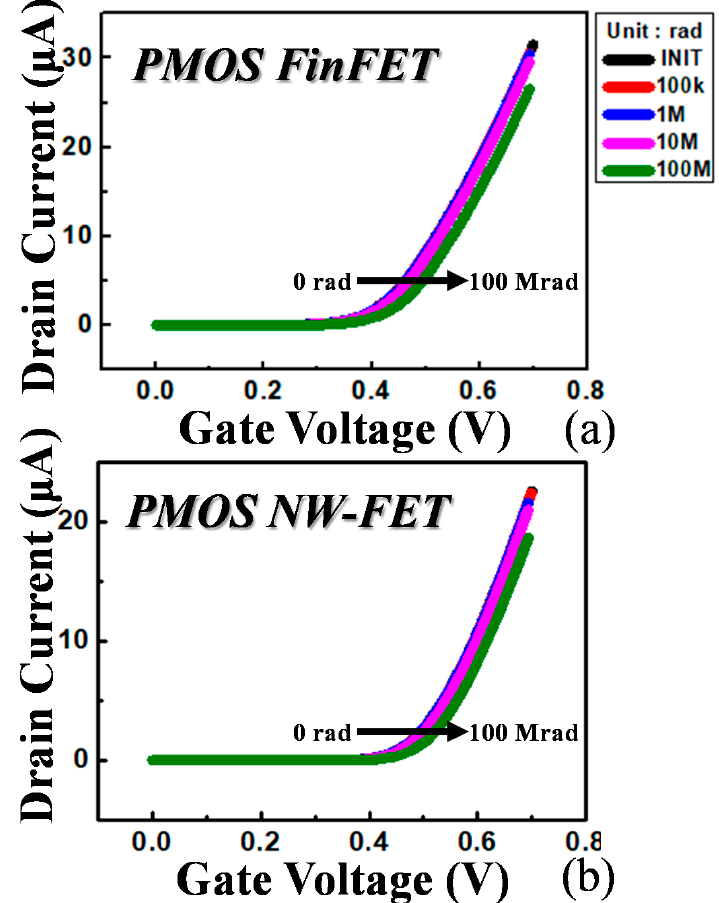
Figure 2. I D –V G curve shift with the increase in the radiation dose up to 100 Mrad. The simulation method sweeps V G from 0 to 0.7 V when the total dose is reached. ( a ) PMOS FinFET; ( b ) PMOS NW-FET.